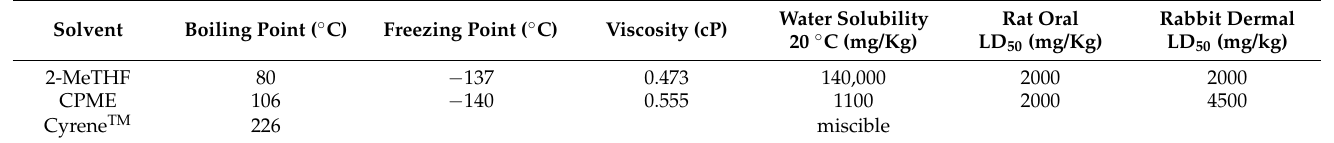
Table 1. Some properties of 2-MeTHF, CPME and Cyrene TM , usual biobased solvents employed in asymmetric